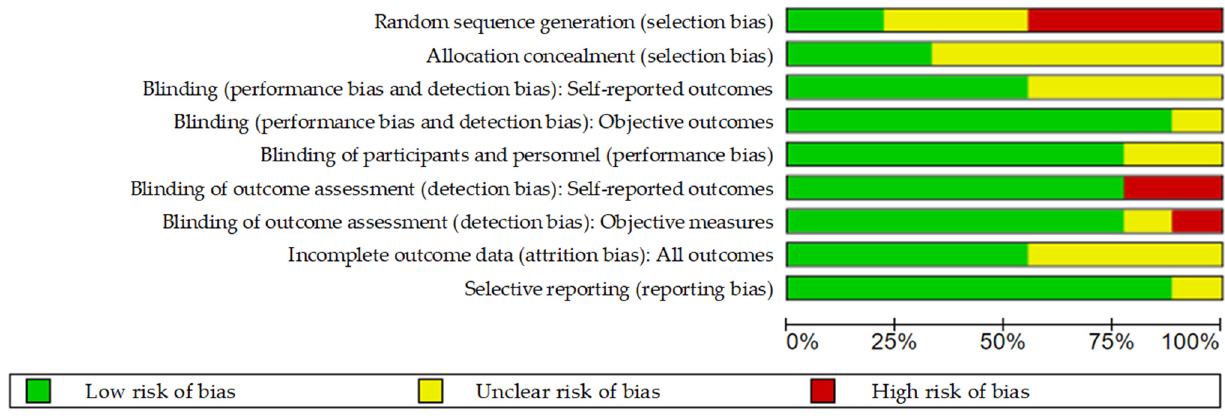
Figure 3. Risk of bias graph.